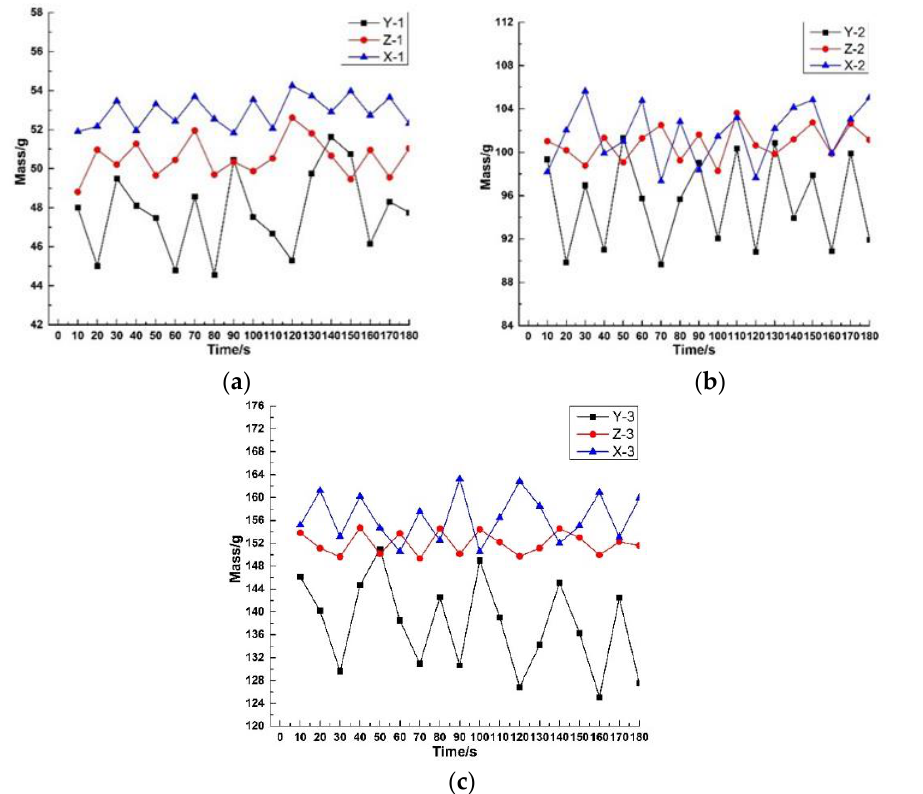
Figure 7. Weight change of rubber block under different extrusion processes: ( a ) The weight of the extruded block when the extruder speed is 10 rpm; ( b ) The weight of the extruded block when the extruder speed is 20 rpm; ( c ) The weight of the extruded block when the extruder speed is 30 rpm. In the same extruder speed, the average weight relationships of the extruded rubber compound is X-1 > Z-1 > Y-1, X-2 > Z-2 > Y-2, and X-3 > Z-3 > Y-3. This is because aramid short fibers mixed in